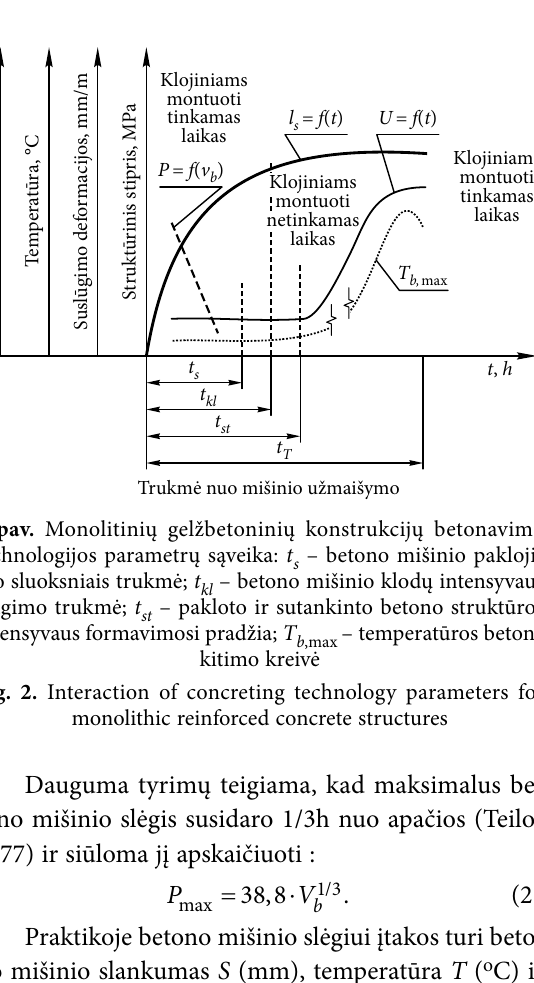
Fig. 1. Use of moving formwork for industrial construction